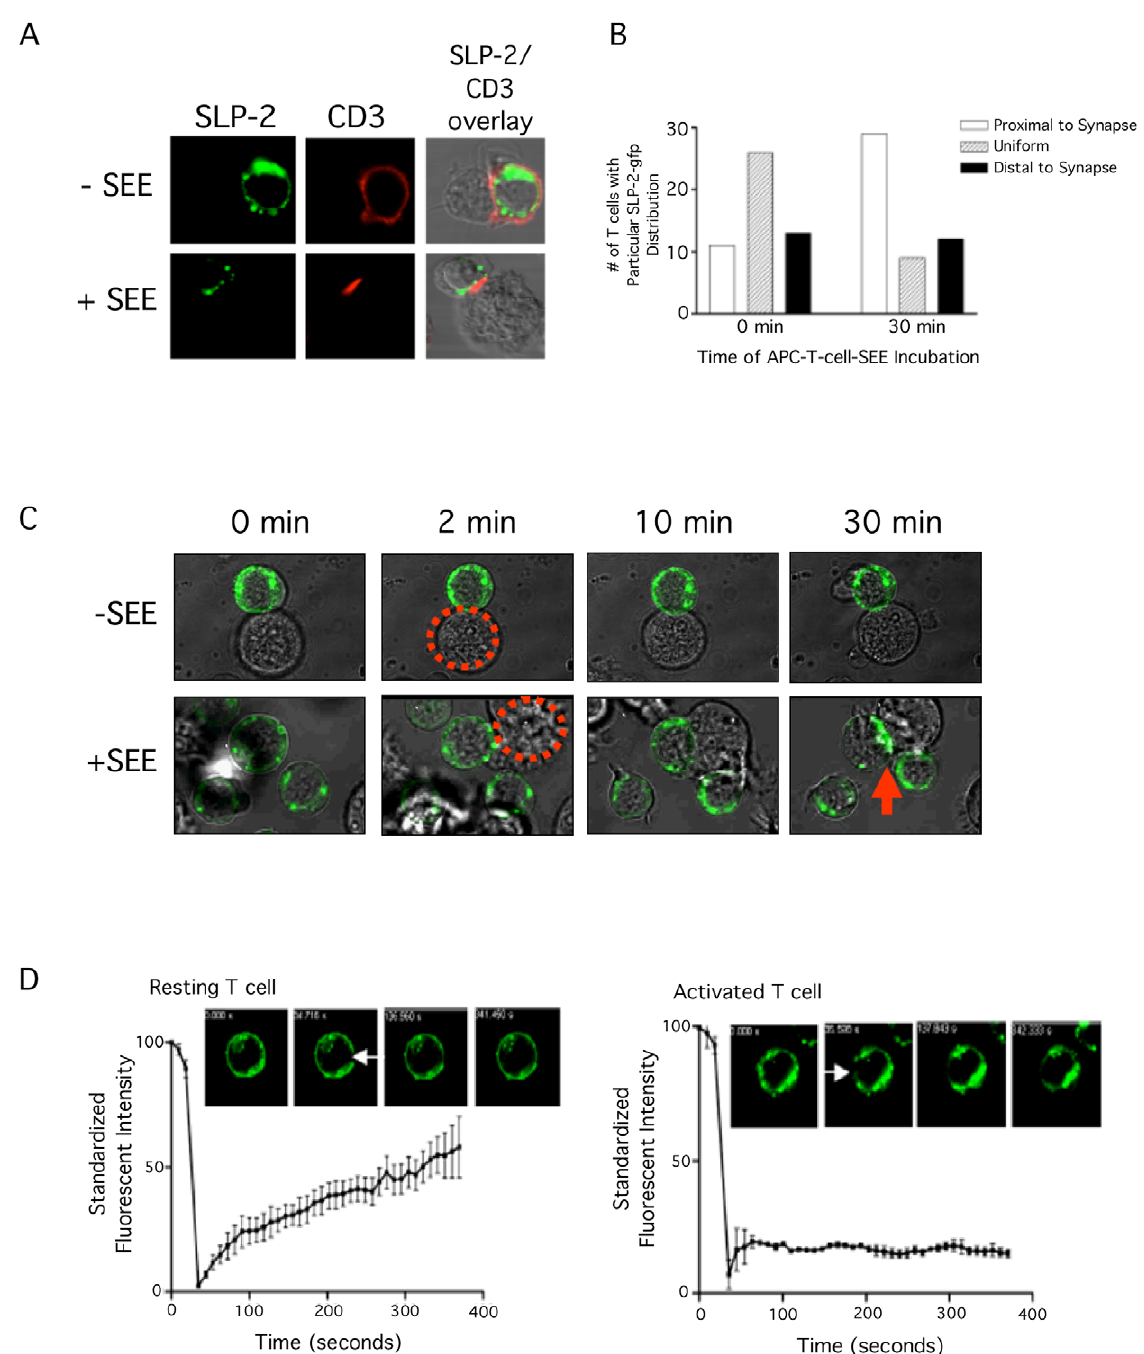
Figure 4. SLP-2 polarizes to the immunological synapse during T cell activation. A) Stable SLP-2-gfp-transfected E6.1 Jurkat T cells were cultured with APC in the presence ( + SEE) or absence ( 2 SEE) of SEE and examined by confocal microscopy for the formation of putative synapses (identified as CD3-positive red clusters at the interface between T cell and APC) and for the location of SLP-2-gfp signal (green). Images are representative of at least 50 putative IS. Concomitant studies done with control transfected T cells demonstrated that expression of SLP-2-gfp did not interfere with IS formation. B) Confocal images collected from 50 putative IS images (in A) were analyzed for SLP-2-gfp intracellular localization. SLP-2- gfp signal in un-stimulated (0 min) or stimulated cells (30 min) was classified as predominantly proximal to the IS (white bars), predominantly distal to the IS (black bars), or diffuse throughout the cell (grey bars). C) Redistribution of SLP-2 during T cell activation is shown by a series of videomicroscopy capture images during IS formation. The dotted circle outlines the APC interacting with the Jurkat T cell and the arrow indicates the mature IS with the SLP-2 localization. See Video S1. D) SLP-2-gfp-transfected Jurkat T cells were stimulated with antibodies against CD3 and examined by confocal microscopy. Photobleaching was induced at the arrow-indicated site and regaining of the signal at that site was monitored for 6 minutes at 20 second intervals. Non-specific distribution is documented by progressive regaining of signal with non-bleached SLP-2, while active distribution correlates with lack of regaining of signal. See Videos S2 and S3 for dynamic data.